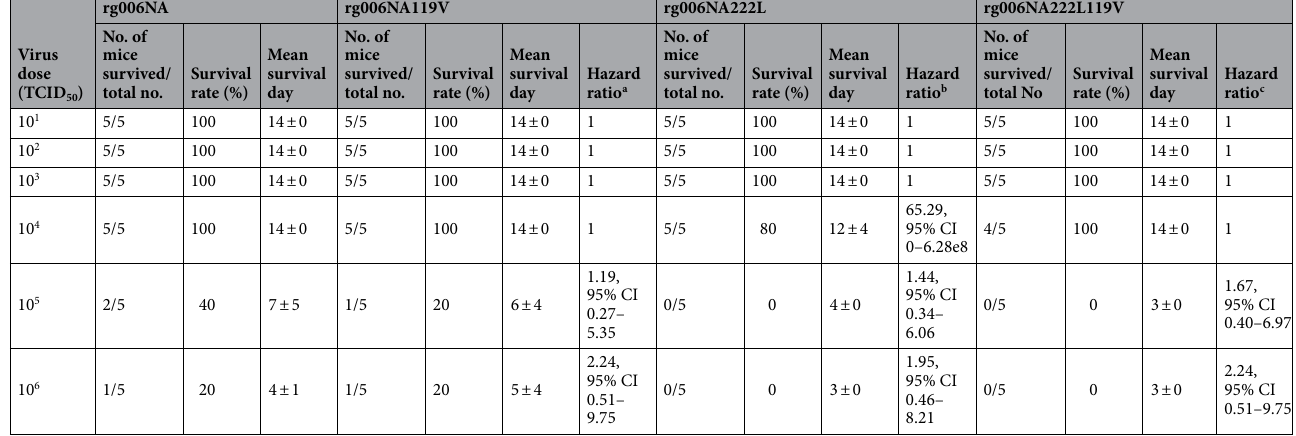
Table 2. Pathogenicity of the reassortment H7N9/PR8 influenza viruses in a C57 mouse model. a